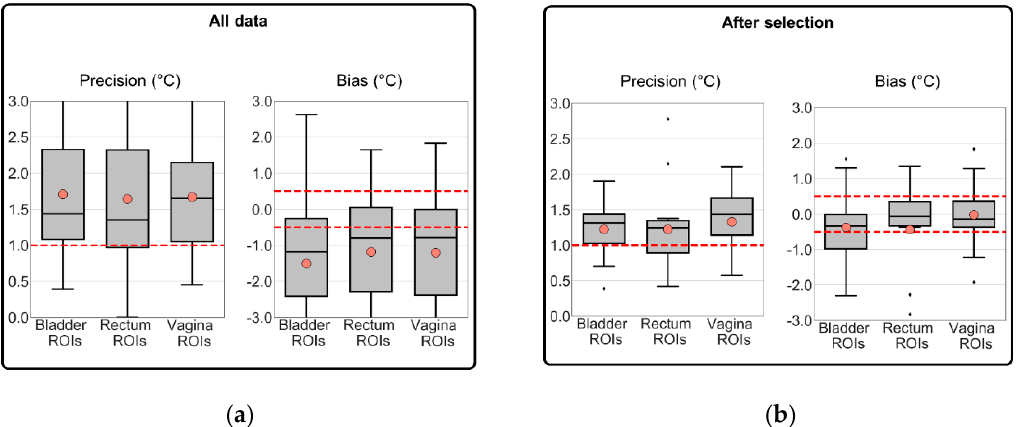
Figure 7. Evaluation of MR thermometry precision and bias in ( a ) all treatment sessions and ( b ) in the group of selected treatment sessions. The MR thermometry was calculated for the three intraluminal locations. The evaluation of MR thermometry was based on the voxels remaining after filtering and data used in the analysis. The dashed red line represents the acceptable mean accuracy threshold (1 °C) and, in light red circles, the mean MR thermometry accuracy in each location. The inter-quartile range denotes the middle 50% of the dataset. The top box shows 75% of the dataset that falls below the upper quartile, while the bottom line consists of 25% of the dataset that falls below the lower quartile. The middle line represents the median value, and the line extending from the box represents 2.5% and 97.5% limits of the dataset.